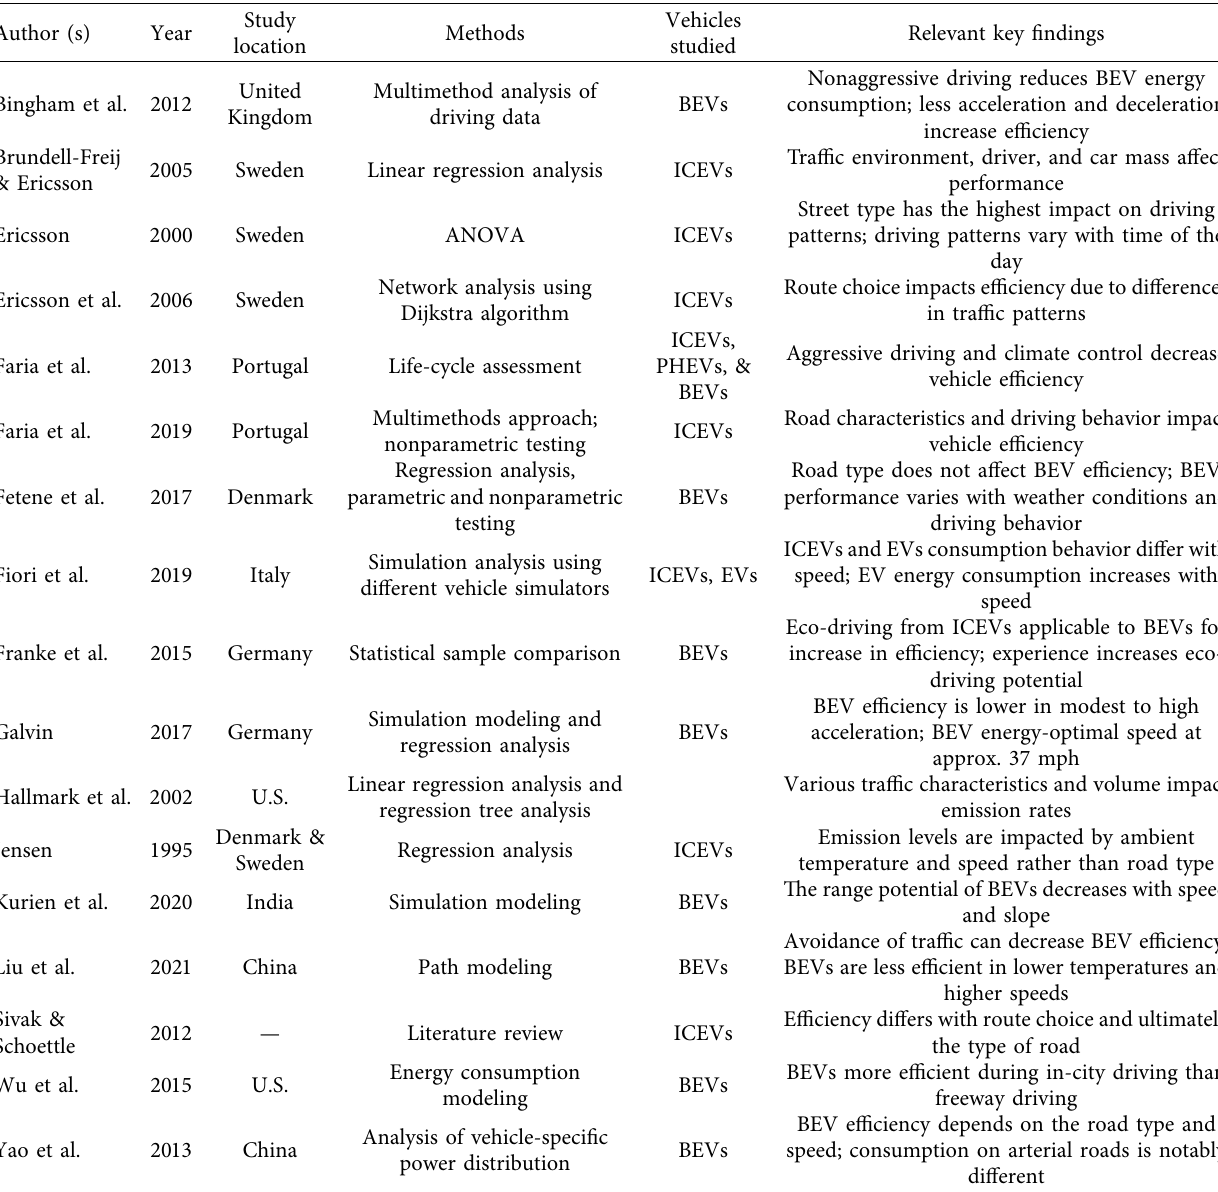
Table 1: Studies relevant for this paper by author, year, location, type of vehicle analyzed, and relevant key findings of the